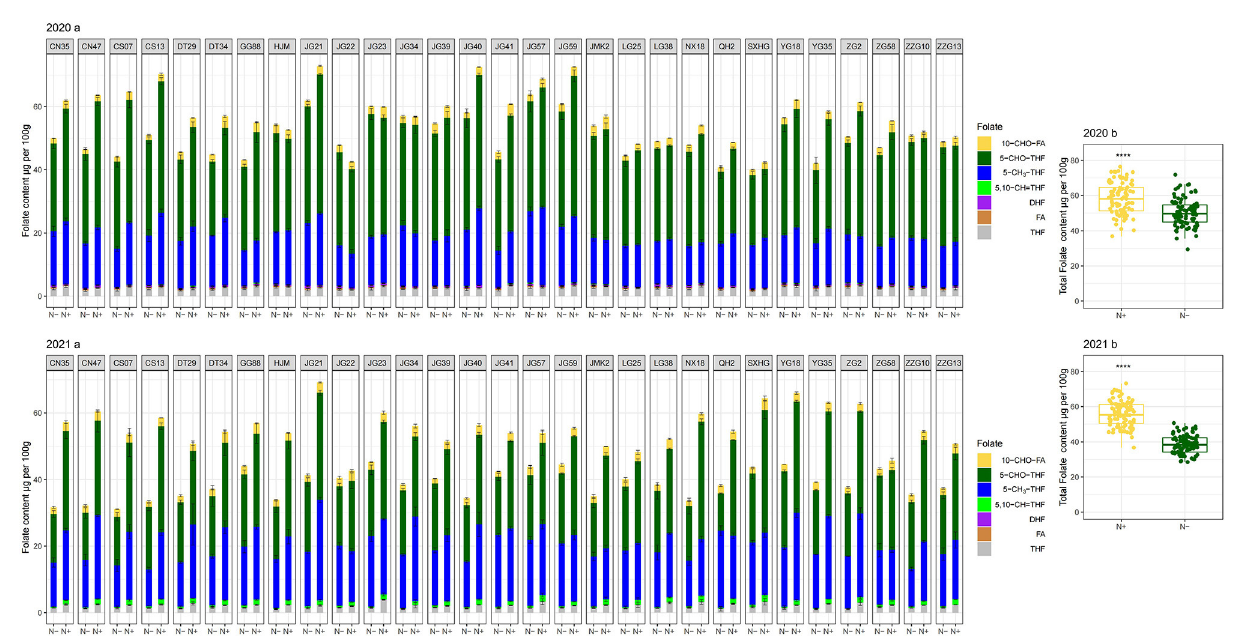
FIGURE2 Folate profiling in folate derivatives of the selected cultivars (2020a in 2020; 2021a in 2021) and the total folate of all cultivars (2020b in 2020; 2021b in 2021) grown with or without N fertilization. CN35, Changnong35; CN47, Changnong47; CS07, Changsheng07; CS13, Changsheng13; DT29, Datong29; DT34, Datong34; GG88, Gonggu88; HJM, Huangjinmiao; JG21, Jingu21; JG22, Jigu22; JG23, Jiugu23; JG34, Jingu34; JG39, Jigu39; JG40, Jingu40; JG41, Jigu41; JG57, Jingu57; JG59, Jingu59; JMK2, JinmiaoK2; LG25, Longgu25; LG38, Longgu38; NX18, Nenxuan18; QH2, Qinhuang2; SXHG, shanxihonggu; YG18, Yugu18; YG35, Yugu35; ZG2, Zhonggu2; ZG58, Zhaogu58; ZZG10, Zhangzagu10; ZZG13, Zhangzagu13; N–, N deficiency; N + , N applied treatment. Error bars represent the standard error of folate derivatives. ****Indicate significant differences at